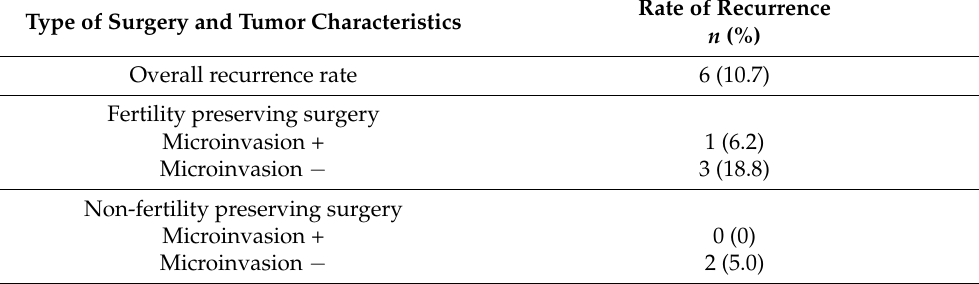
Table 3. Rate of recurrence.